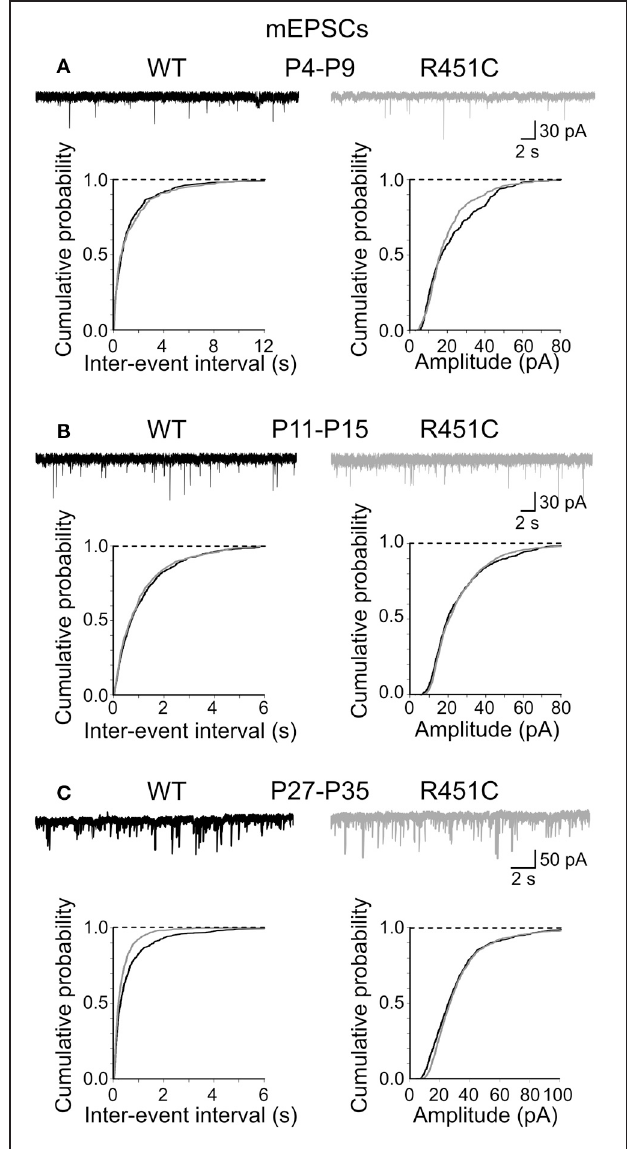
FIGURE 3 | The NL3 R451C knock-in mutation does not affect spontaneous miniature glutamatergic events. (A) Samples traces of mEPSCs recorded from CA3 principal cells at P4–P9 from WT (black) and in NL3 R451C knock-in mice (gray). Below, cumulative probability plots of inter-event intervals (left) and amplitude (right) of obtained from P4–P9 (A) , P11–P15 (B) , and P27–P35 (C) WT and NL3 R451C knock-in mice. (B) and (C) as (A) but for later developmental stages. Note changes in frequency (but not amplitude of miniature events at P27–P35 (the two curves are significantly different; p < 0 . 05; K–S